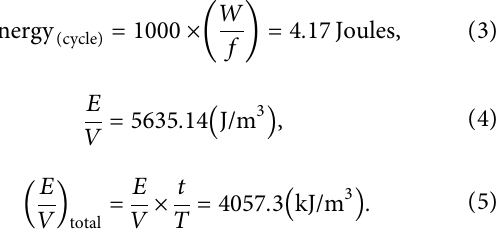
Table 1: Relative settling difference in two precipitation modes. Relative meeting amount Grading